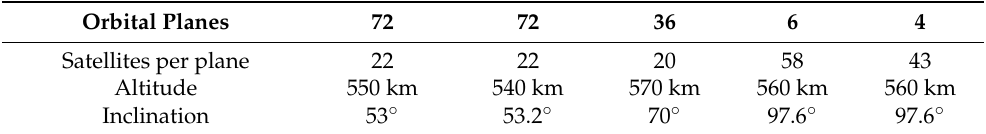
Table 2. Starlink Deployment Summary.